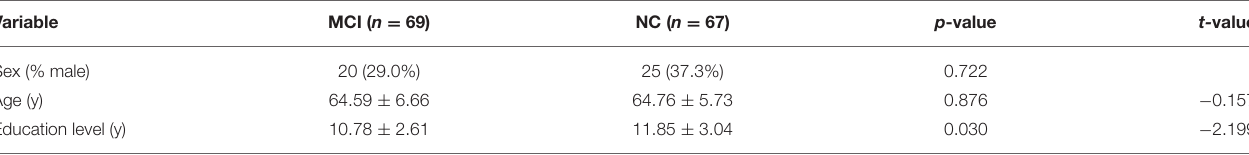
TABLE 1 | Descriptive data for the general characteristics ( N = 136). Variable